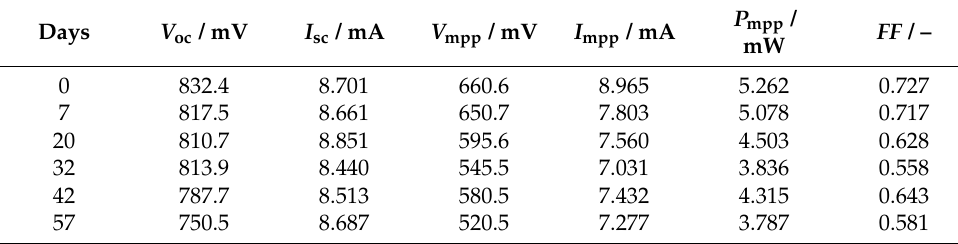
Table 1. The essential measured parameters during the illumination process of I–V curves. Each row in the table indicates the relevant day after illumination. The first row where the value is 0 days shows the measurement before the start of the process. Selected parameters are open-circuit voltage V oc , short-circuit current I sc , voltage at MPP V mpp , current at MPP I mpp , power at MPP P mpp , and fill factor FF . The most decreased photovoltaic parameter of the cell can be considered fill factor during the 32nd day. There is a decay after stabilization, which is caused by chemical processes in the